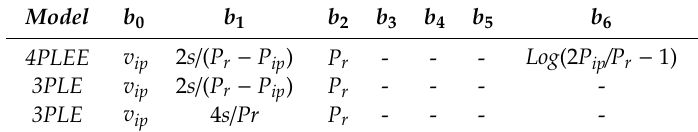
Table 6. Relationship among parameters of the exponential models and the parameters of the WT. Model b 0 b 1 b 2 b 3 b 4 b 5 b 6 4PLEE v ip 2 s / ( P r − P ip ) P r - - - Log (2 P ip / P r − 1) 3PLE v ip 2 s / ( P r − P ip ) P r - - - - 3PLE v ip 4 s / Pr P r - - -